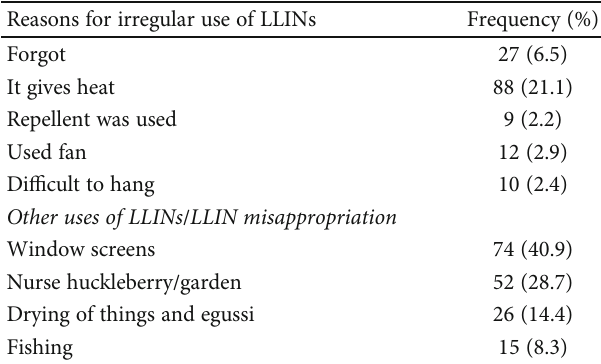
Table 4: Rationale for irregular use of